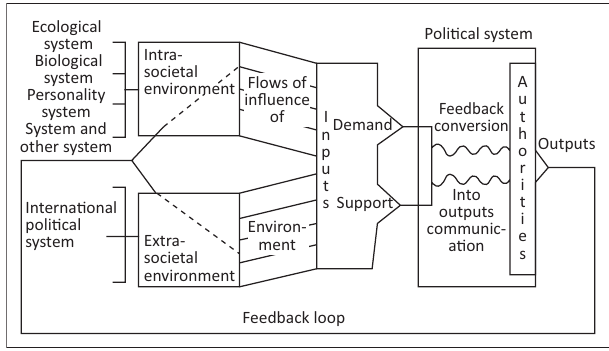
FIGURE 1: Dynamic model of Easton’s political